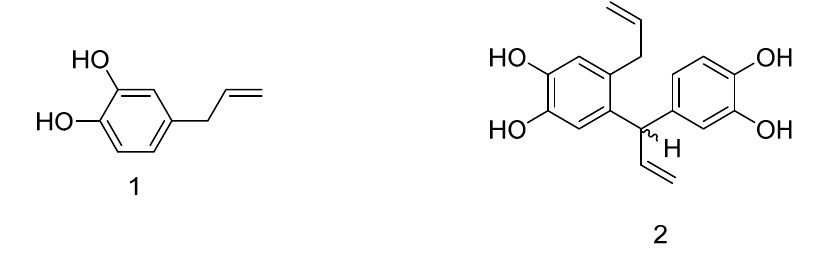
Figure 1. The chemical structures of the antibacterial active compounds from Piper austrosinense : 4-Allylbenzene-1,2-diol ( 1 ); (S)-4-allyl-5-(1-(3,4-dihydroxyphenyl)allyl)benzene-1,2-diol ( 2 ).